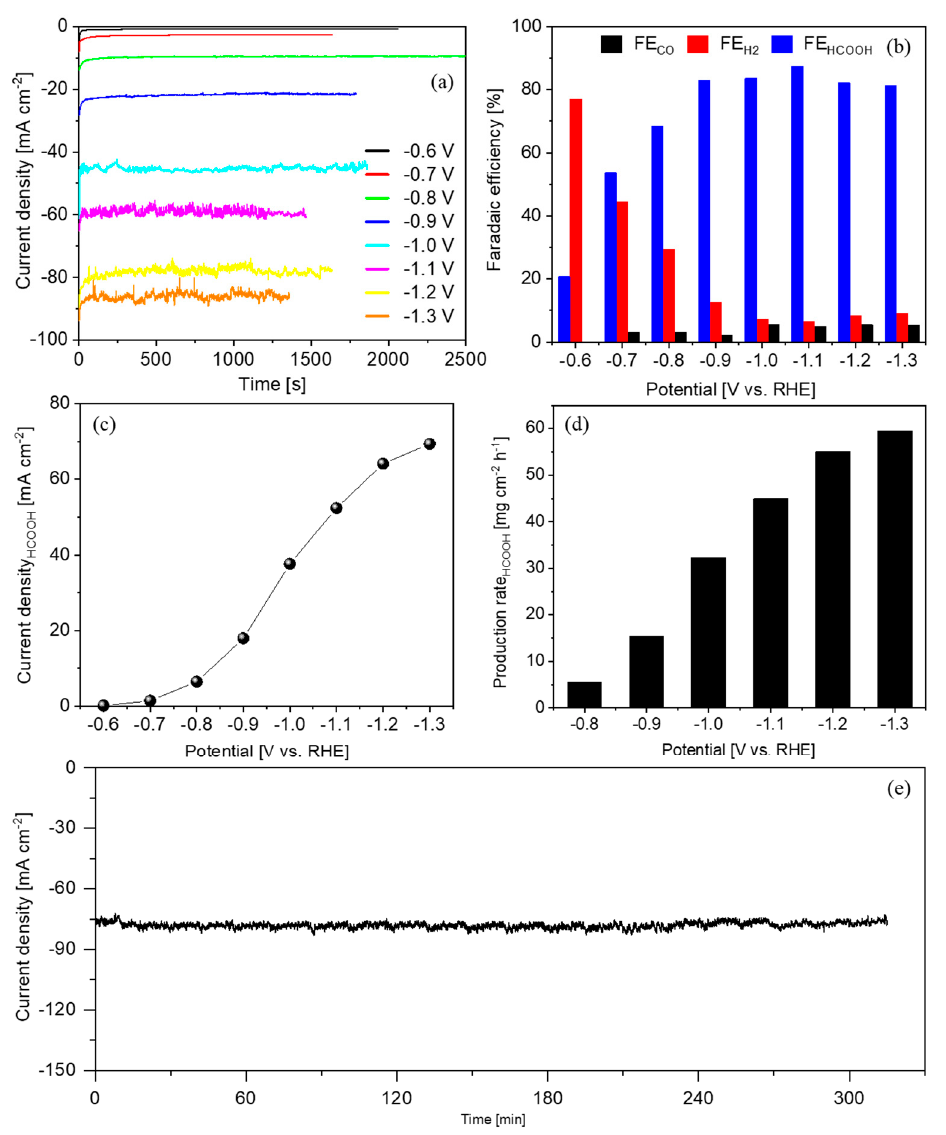
Figure 7. CO 2 RR on the biochar–Bi 2 O 3 electrode in 2.0 M KHCO 3 electrolyte: ( a ) chronoamperometric tests at various potentials, ( b ) faradaic efficiency of the main products, ( c ) partial current density for HCOOH formation, ( d ) the production rate of HCOOH and ( e ) long-term test at − 1.2 V.